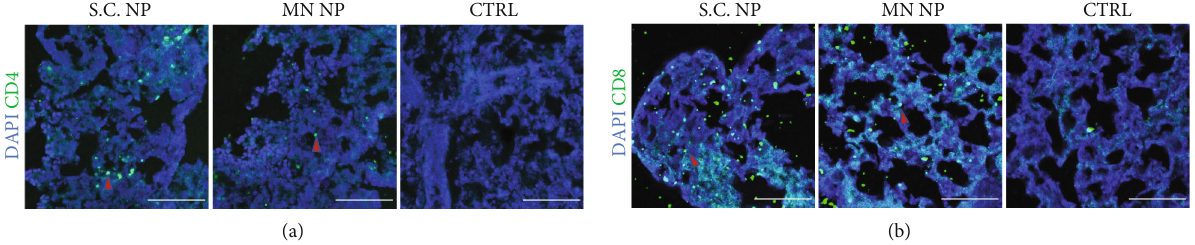
Figure 4: Immunohistochemical staining of lung tissues from MN-based NP immunized mice. At day 29, mice from the S.C. NP immunization group, MN NP immunization group, and vehicle control groups were sacri fi ced and lung tissues were collected and subjected to IHC staining of CD4 (a) and CD8 (b) markers. Sections were viewed under LSM800 confocal microscope. Scale bars, 100 μ